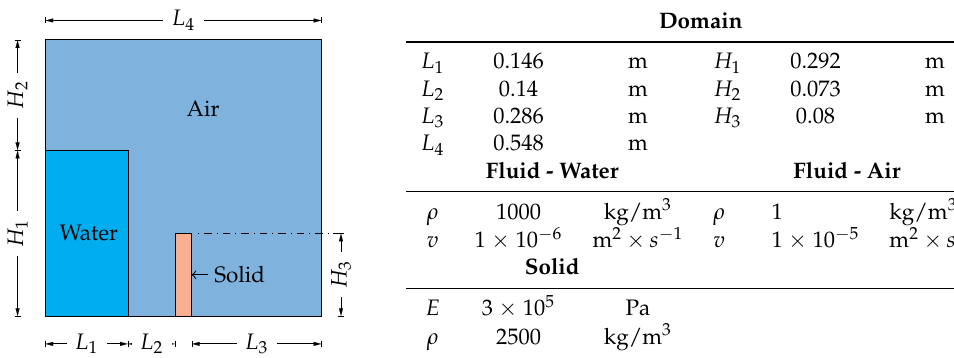
Figure 4. Domain geometry—not to scale—( left ) and dimension and material parameters ( right ) of the Breaking-Dam-2D test case.